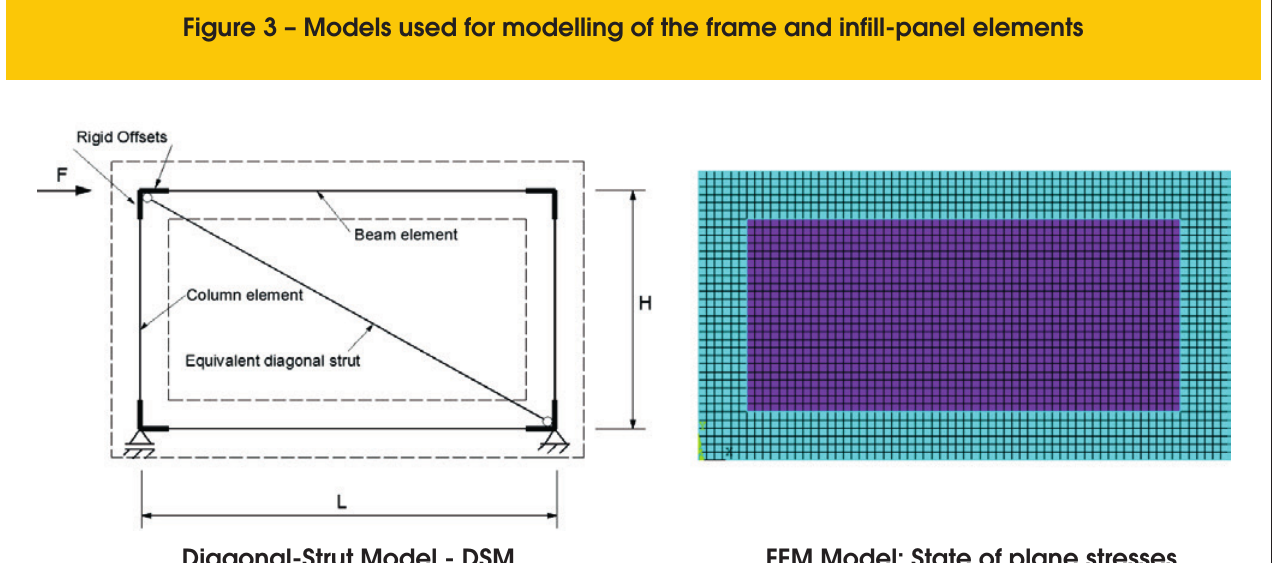
Figure 3 – Models used for modelling of the frame and infill-panel elements